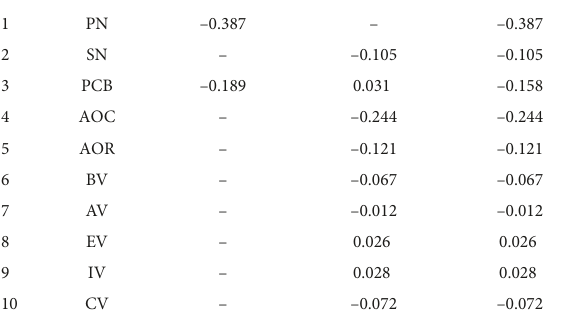
TABLE 6 Analysis of direct, indirect, and total effects of the variables on conflict behavior of